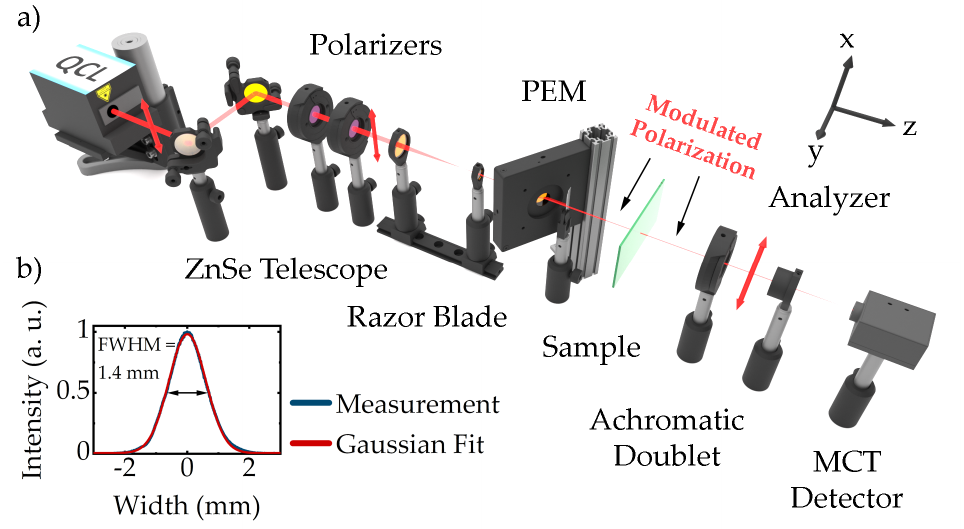
Figure 1. ( a ) Experimental Setup. The QCL radiation is guided through a set of two Si wire grid polarizers. Before the polarization state is modulated using a PEM, the beam waist is reduced. Thereby, reflections occurring inside the tilted PEM can be blocked by the subsequent razor blade. After interaction with the sample the radiation passes a third Si polarizer (analyzer) and is focused on an MCT detector by means of an achromatic doublet lens. ( b ) Beam waist at sample position measured with a microbolometer FPA at an exemplaric wavelength of 1052cm − 1